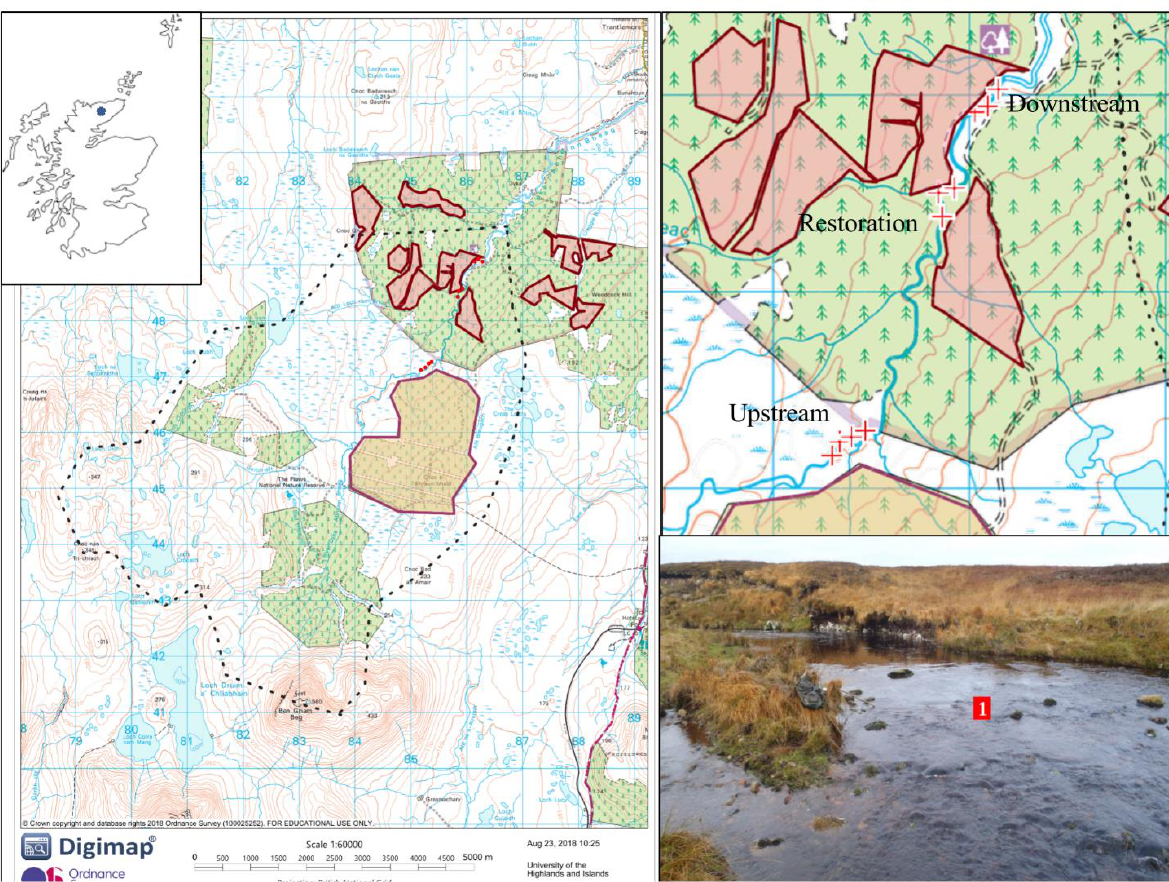
Figure 1. Details of the study location. Inset: blue star indicates location of the study in Scotland. a) Map of the sub-catchment (dotted black line indicates its boundary) located in the RSPB’s Forsinard Flows NNR around the Dyke forest, which receives water from open bog, forestry plantations (green areas), older forest- to-bog restoration areas (restoration in 2005–2006; yellow-brown shading) and areas within the plantation undergoing restoration during the study (red shading). b) Locations, marked by crosses, of the sampling points along the Dyke River within the sub-catchment upstream ( n = 4), within ( n = 3) and downstream ( n = 3) of the areas undergoing active forest-to-bog restoration management. c) Photograph of the first upstream sampling location (indicated by the red label) within the Dyke